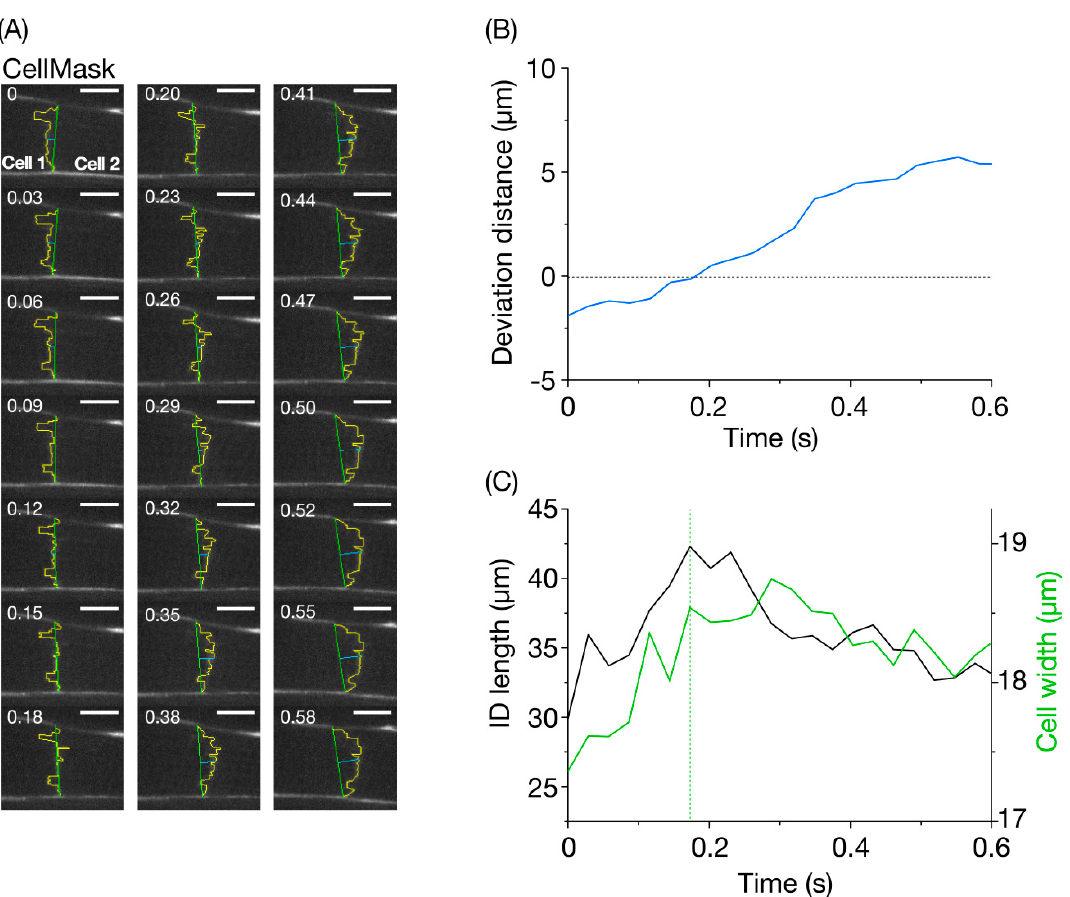
Figure 3. Imaging of the intercalated disc in the CellMask-treated left ventricle of the living mouse heart in vivo. ( A ) Confocal images of the intercalated disc (ID) at varying time points. Cell 1 and Cell 2 are located on the left and right side of the ID, respectively. Number on the top left in each figure indicates the time point at which the image was obtained. The ID was traced by a yellow line. Vertical green line, cell width, horizontal blue line, deviation of the ID at the center from the mid-point of vertical green line (see Materials and Methods). The heart in an open-chest mouse was excited using a laser at 532 nm, and imaging was performed at 34 frames / s for 0.58 s. Bar on top right, 10 µ m. ( B ) Time course of changes in the deviation distance for the ID (shown in blue). Deviation distance was defined as the length of the horizontal blue line in ( A ). The value became zero at 0.18 s. ( C ) Time course of changes in the ID length and cell width. Black line, ID length (total length of the yellow line in ( A )); green line, cell width. Cell width represents the width of Cell 2 and Cell 1, respectively, before and after 0.18 s (at which deviation distance became zero, see ( B )).